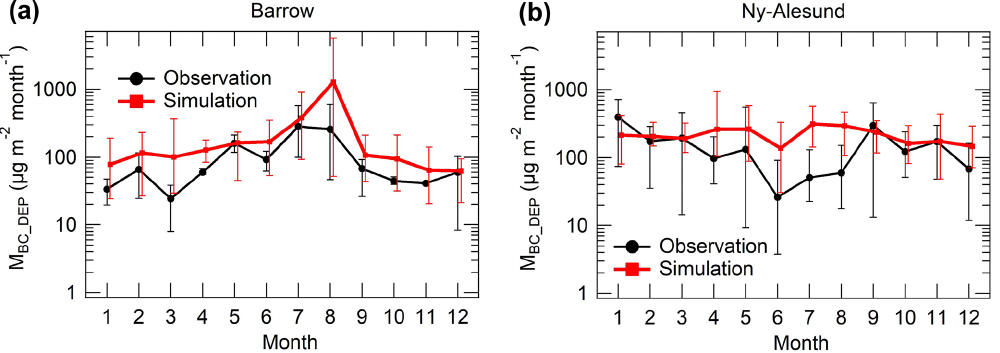
Figure 3. Comparisons between observations (black) and model simulations (red) for BC deposition flux ( M BC_DEP ) at (a) Utqia ˙ gvik (formerly Barrow) and (b) Ny-Ålesund. Model simulations in 2009–2015 were compared with observations in 2013–2017 because M BC_DEP observation data are available during 2013–2017. The error bars show the interannual variability (maximum–minimum ranges) of M BC_DEP